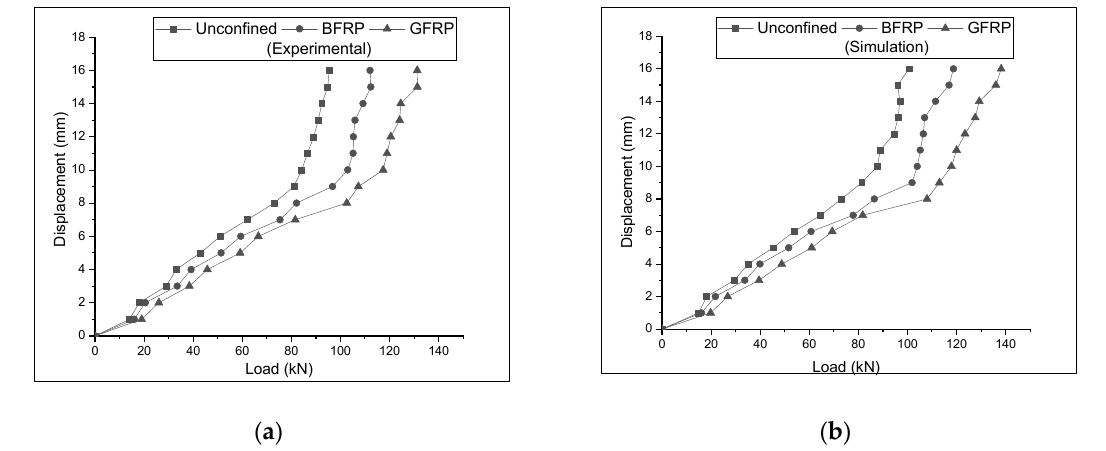
Figure 17. Load vs. settlement (dry state): ( a ) Experimental ( b ) Simulation.